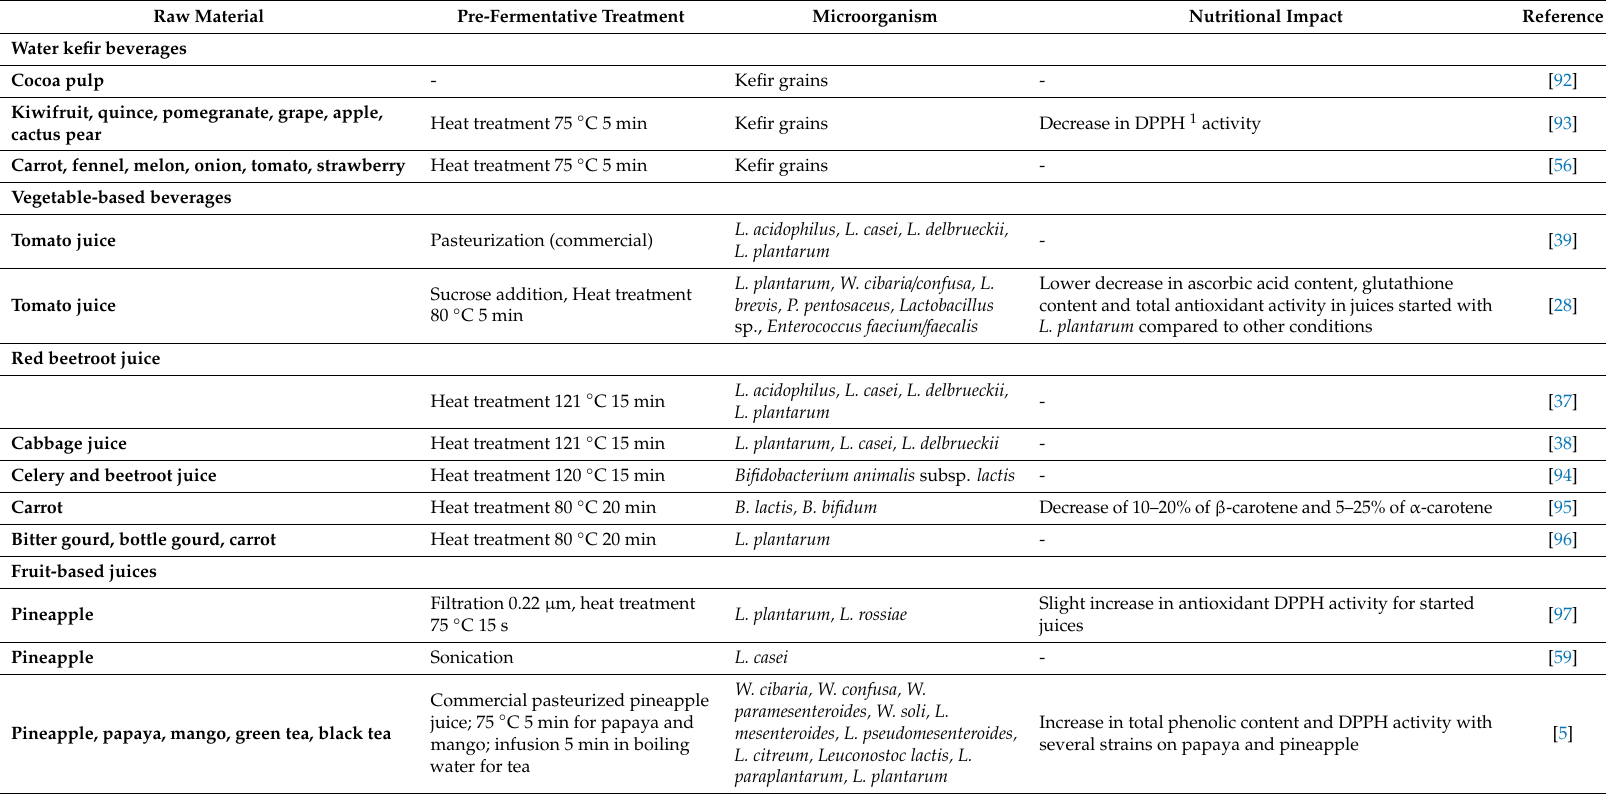
Table 2. Lactic fermented fruit or vegetable juices recently